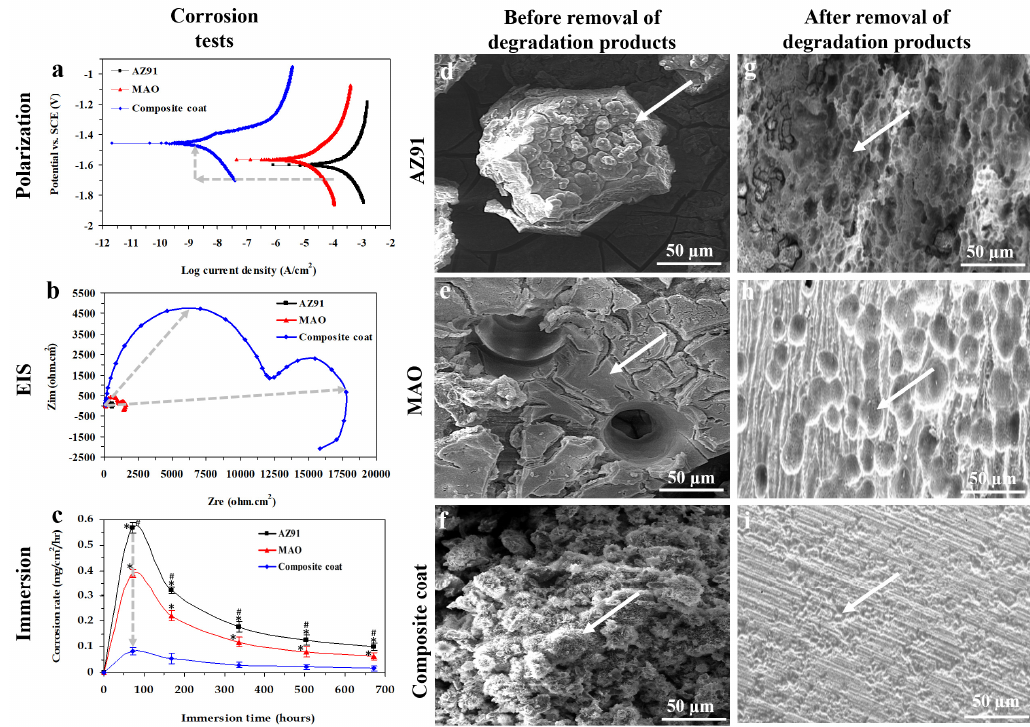
Figure 4. Corrosion tests: ( a , b ) Results of electrochemical corrosion tests include potentiodynamic polarization ( a ), EIS ( b ) and ( c ) immersion test showing that the corrosion rate of AZ91 Mg alloy substrate reduced following MAO and nanocomposite coating; ( d – i ) SEM images of AZ91 ( d , g ), MAO ( e , h ), and nanocomposite coated ( f , i ) samples after 672hr in SBF. Images have been taken before ( d – f ) and after ( g – i ) removal of degradation products. SEM images show that the cracks and pits formed on the AZ91 sample due to the corrosion were significantly more than MAO and nanocomposite coated samples. Furthermore, the surface of nanocomposite coated samples had been totally covered with cauliflower-like white particles. Significant di ff erences: * p < 0.05: AZ91 vs. MAO or Composite coat, # p < 0.05: MAO vs. Composite coat.